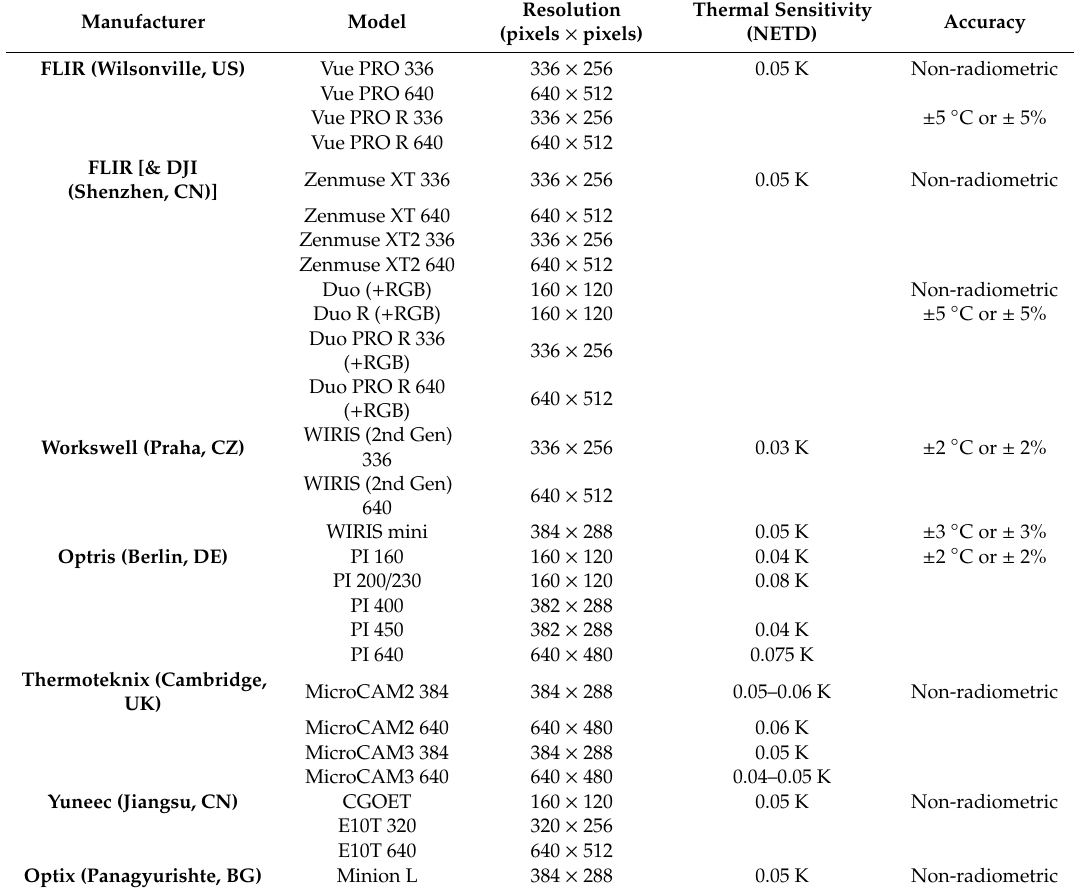
Table 1. Some commercial thermographic cameras for aerial platforms (updated from Reference